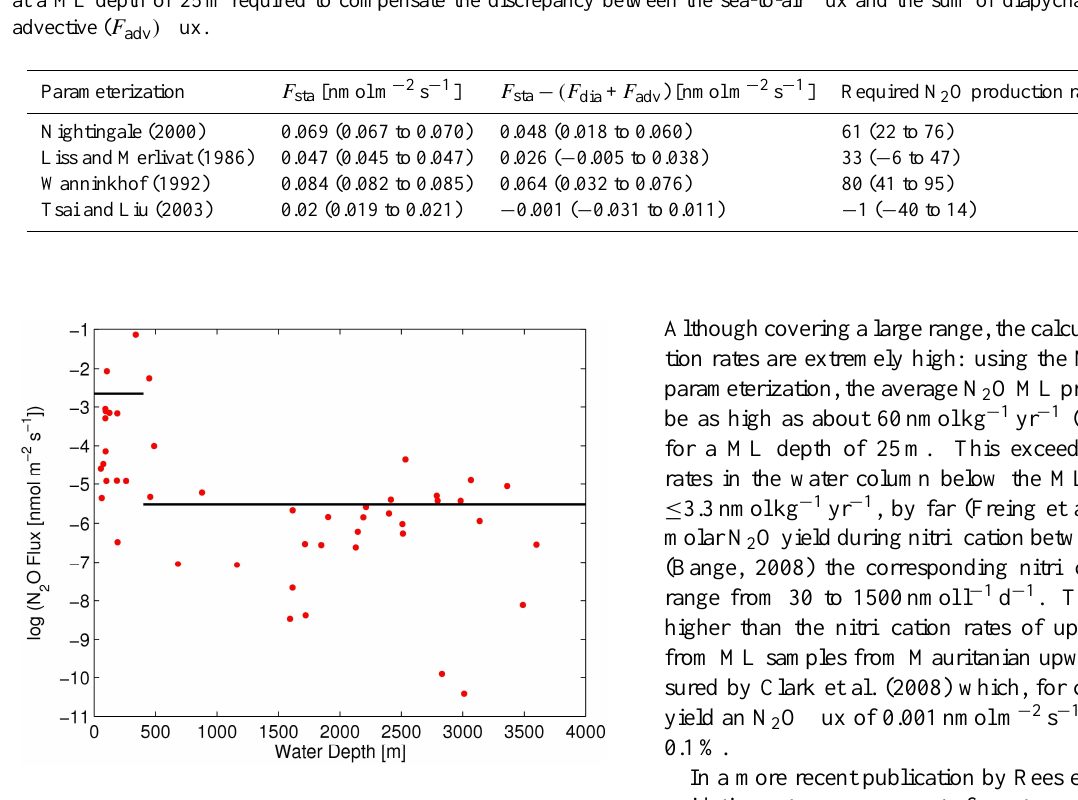
Fig. 5. Diapycnal N 2 O fluxes vs. water depth. The black lines denote average fluxes for the shelf and for the open ocean